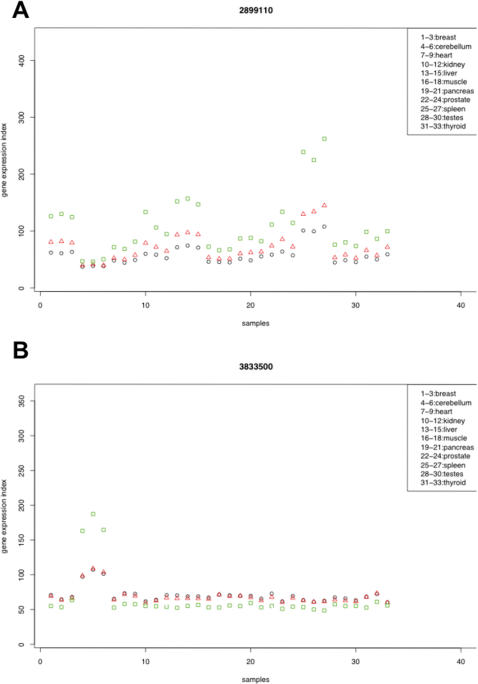
Gene expression indexes computed using all probes, all core probes, and selected core probes.(A) Gene expression indexes of transcript cluster 2899110 (HFE) are computed using all probes (black circles), all core probes (red triangles) and selected probes (green rectangles).Probe selection increases the gene expression indexes computed for all the samples.The relative expression levels in different tissues remain unaltered.(B) Gene expression indexes of transcript cluster 3833500 (SPTBN4, a gene known to be overexpressed in brain and cerebellum).Probe selection strengthens the pattern of overexpression in cerebellum (sample #4, #5 and #6).